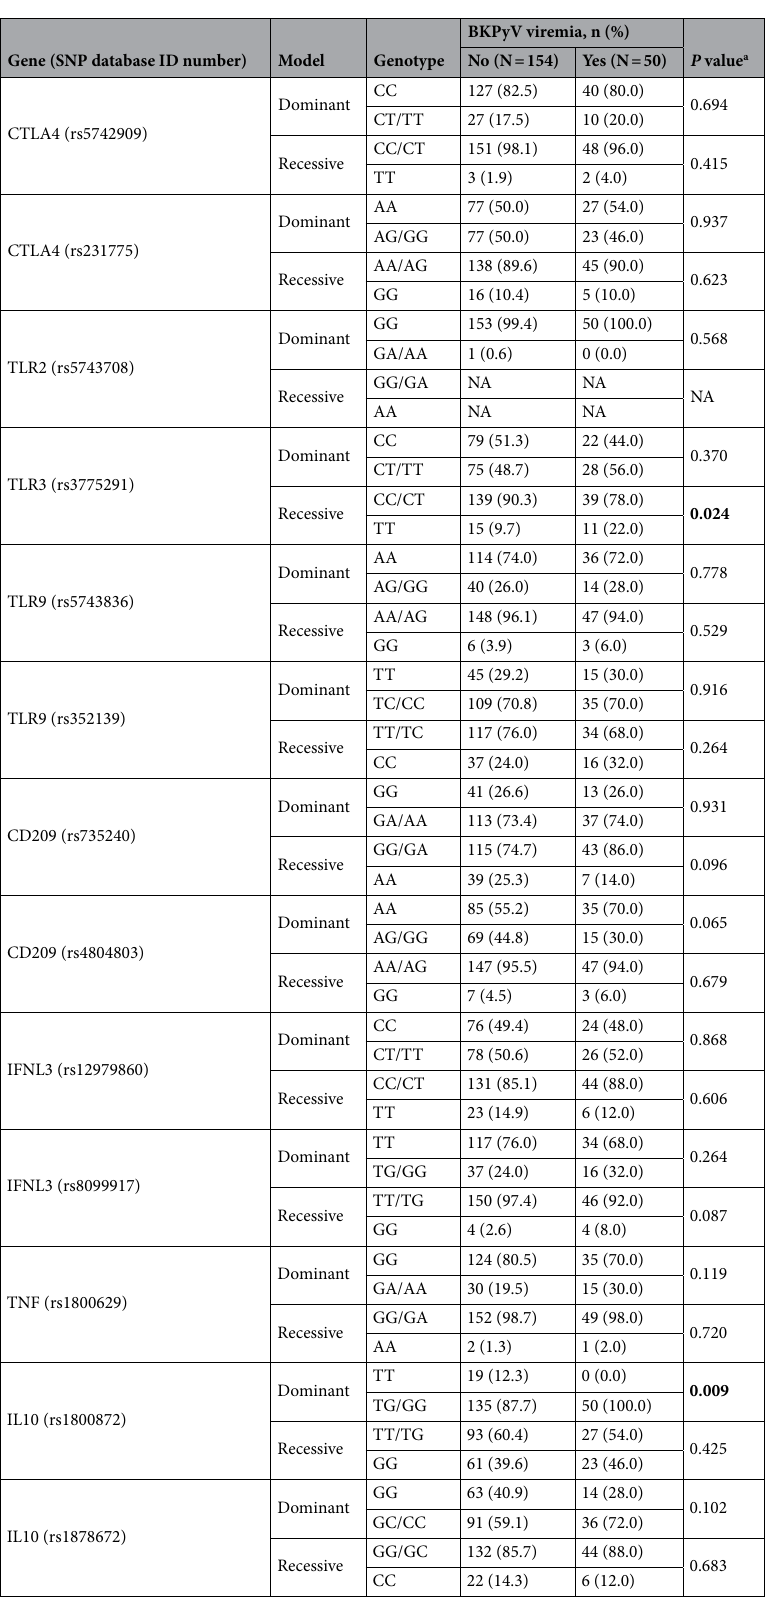
Table 4. Associations between the cumulative incidence of BKPyV viremia and genotype combinatons of candidate SNPs according to dominant or recessive models. BKPyV BK polyomavirus; CTLA-4 cytotoxic T-lymphocyte antigen 4; IL interleukin; N/A not applicable; SNP single-nucleotide polymorphism; TLR toll- like receptor; TNF tumor necrosis factor. a Bold characters indicate significant P